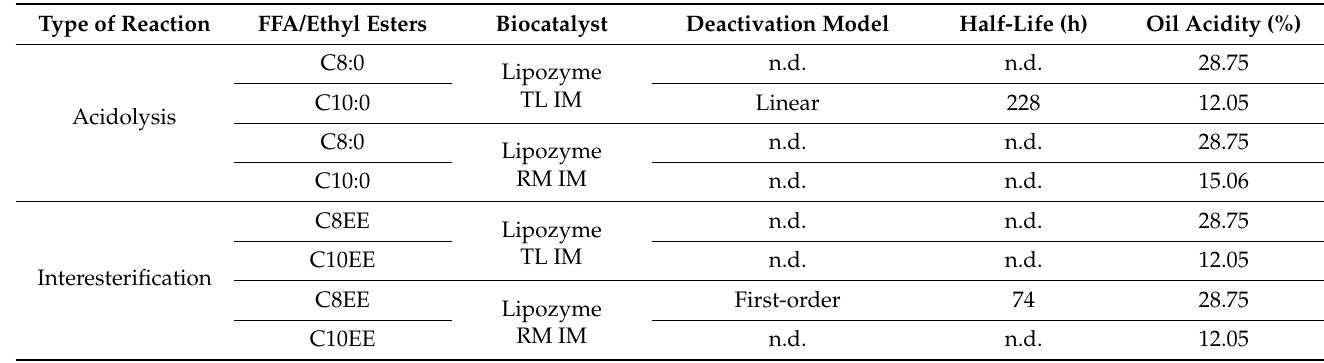
Table 2. Operational stability results for Lipozyme TL IM and Lipozyme RM IM, in a continuous bioreactor (deactivation kinetics model and half-life, h) for acidolysis and interesterification reactions, with OPOs of different acidity values (n.d.: not